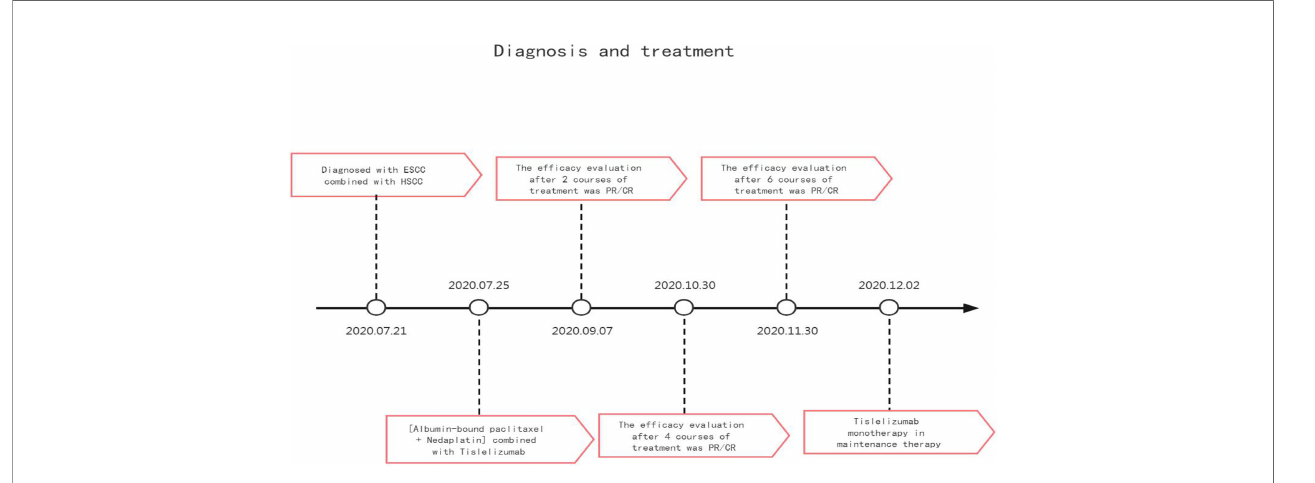
FIGURE 6 | Time fl ow chart of the diagnosis and treatment process of this patient.